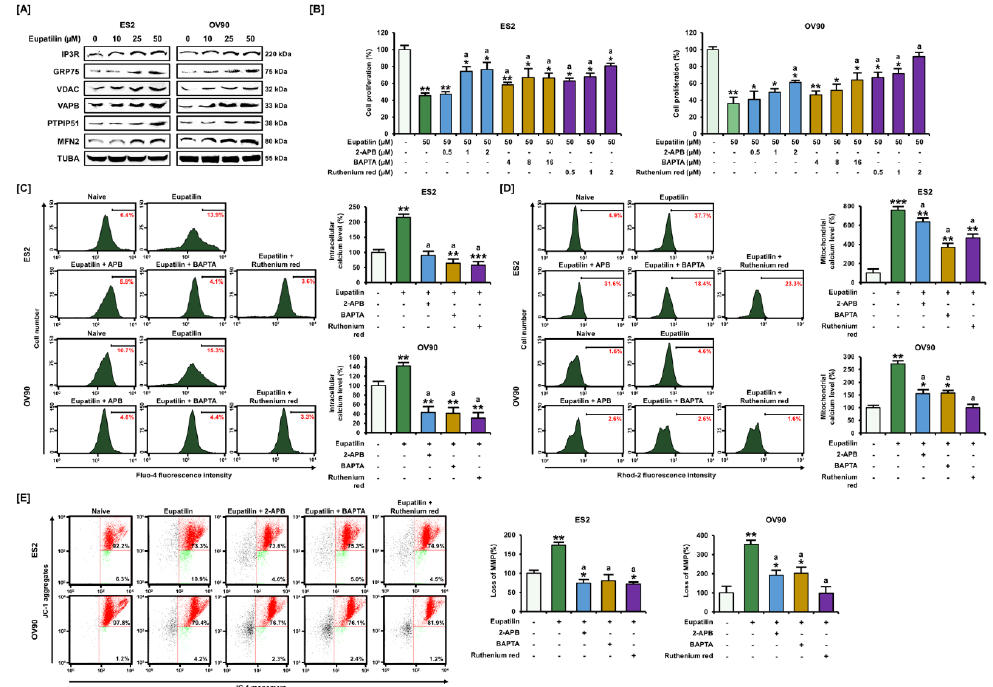
Figure 3. Calcium-induced pathway using specific calcium channel inhibitors with